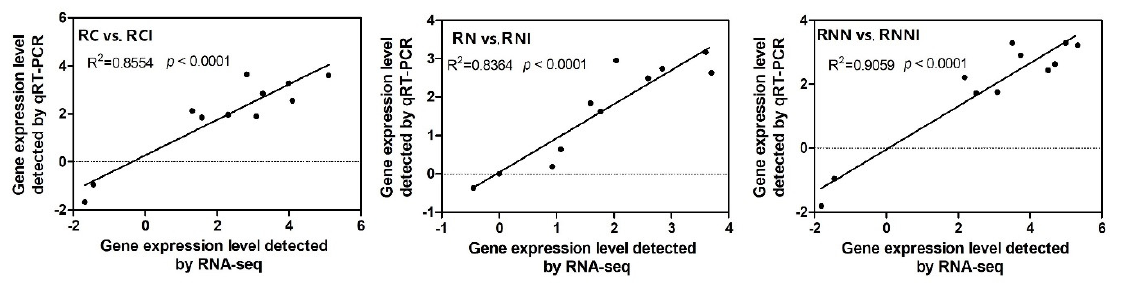
Figure 4. Correlation analysis of DEGs between qRT-PCR analysis method and RNA-Seq experiments. 3.4. Imidacloprid Inhibited Nitrate Absorption in the Roots and Reduced Nitrogen Assimilation in the